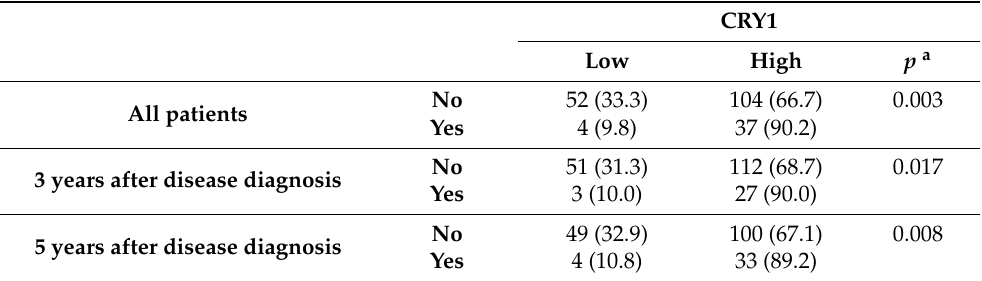
Table 6. Relationship between expression levels of circadian proteins and development of MM after disease diagnosis of individuals included in the study.